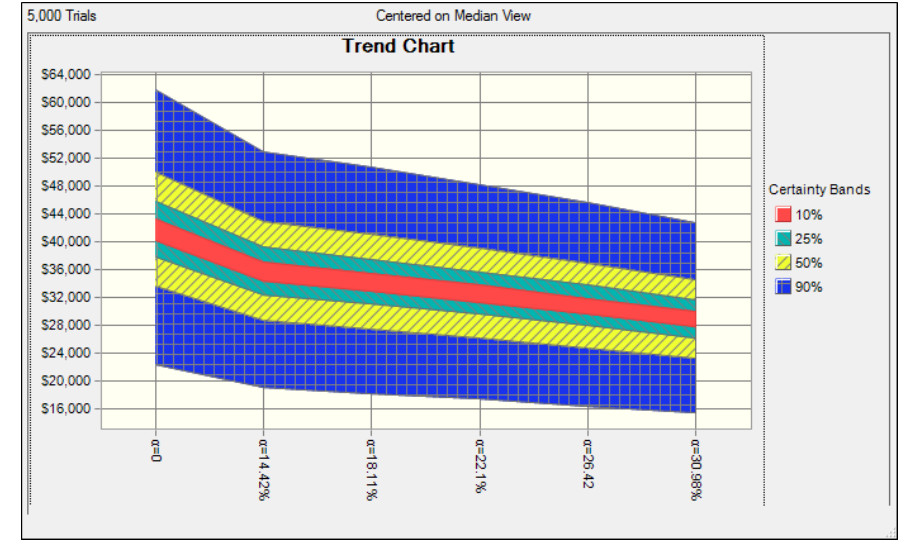
Figure 8. Sensitivity Diagram of pollutant charges to peak-shaving ratio.